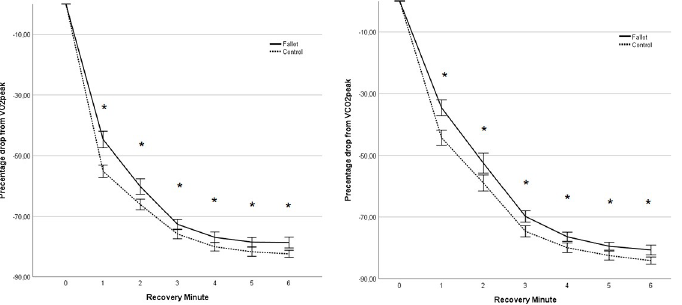
Fig 2. Recovery of VO 2 (A) and VCO 2 (B) as percentage of peak value during the 6 min of recovery of the rToFpatients (Fallot) and the control group (Control). � : statistically significant difference p < 0.05.